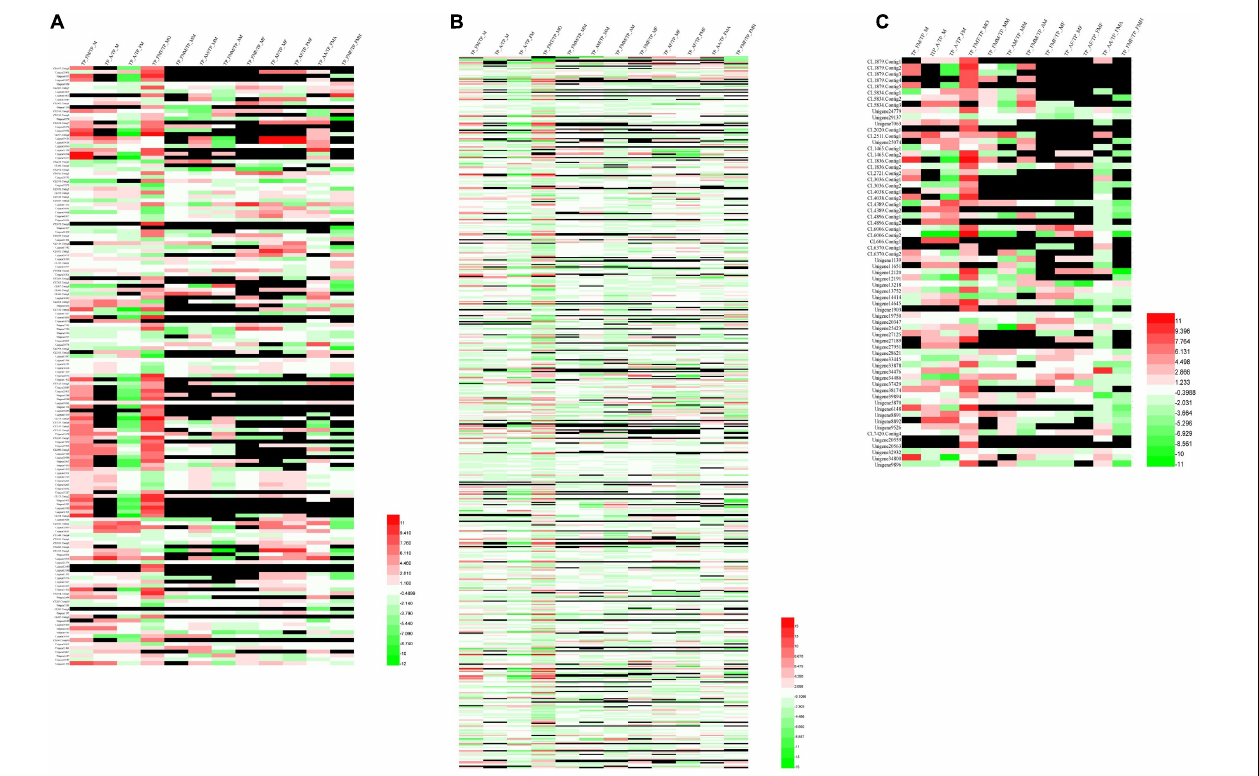
FIGURE 6 | Cluster analysis of differential genes among different tissue samples and different developmental stage. (A) Genes related to growth and development. (B) Genes of digestion and detoxification enzymes. (C) Genes of olfactory.